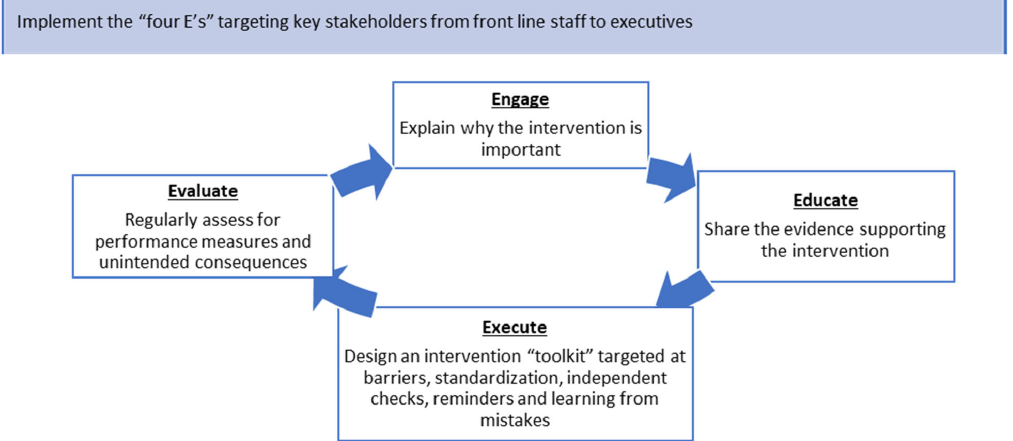
Figure 1. A model to implement quality improvement intervention in a healthcare